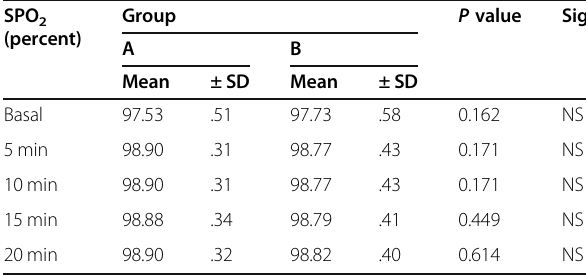
Table 4 Comparison between ESA and PBA as regards